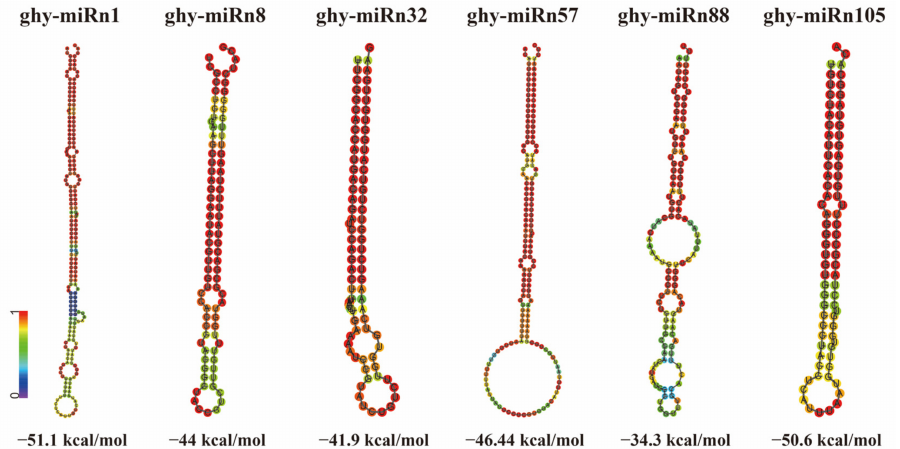
Figure 4. Predicted stem-loop structures of six novel miRNAs identified in gerbera. The stem-loop structures are colored by base-pairing probabilities, red: high probability, purple: low probability. kcal/mol: the minimum free energy of the stem-loop structures.